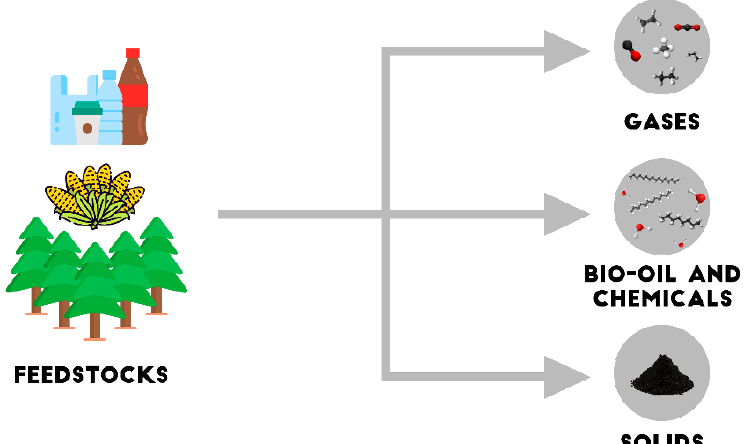
Figure 2. The main products of biomass pyrolysis.